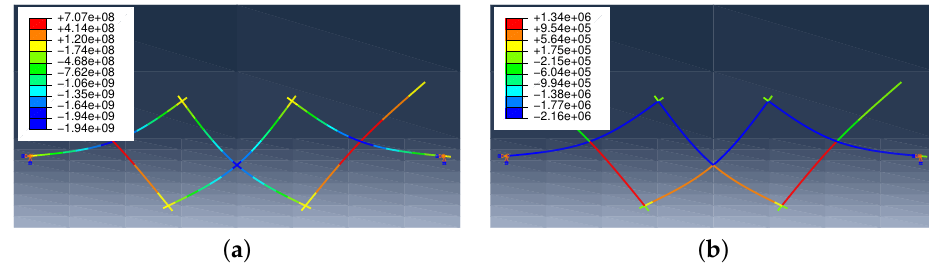
Figure 12. Distribution of sectional forces (response magnification 100 times): ( a ) bending moment distribution; ( b ) axial force